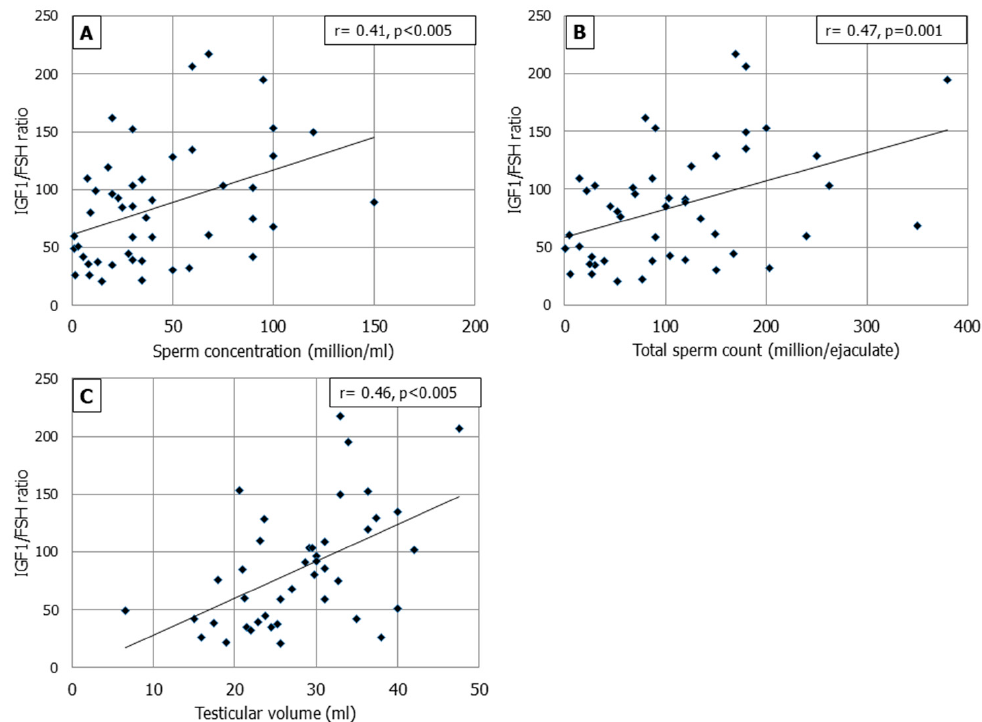
Figure 1. Correlation of IGF1/FSH ratio and sperm concentration, total sperm count, and testicular volume. IGF1/FSH positively correlate with sperm concentration ( panel A ), total sperm count ( panel B ), and testicular volume ( panel C ) in the entire cohort (n = 59). Table 3. Range and baseline values of Groups 1 and